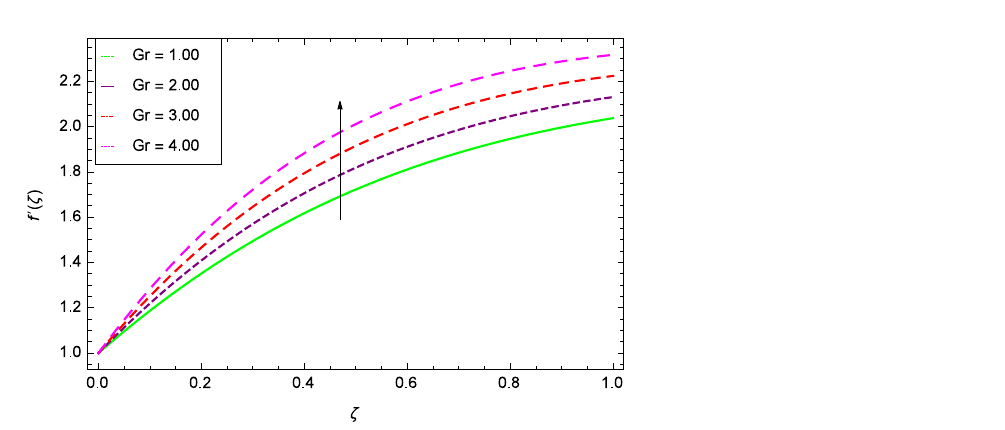
Figure 9. Parameter effect on velocity f ′ (ζ)